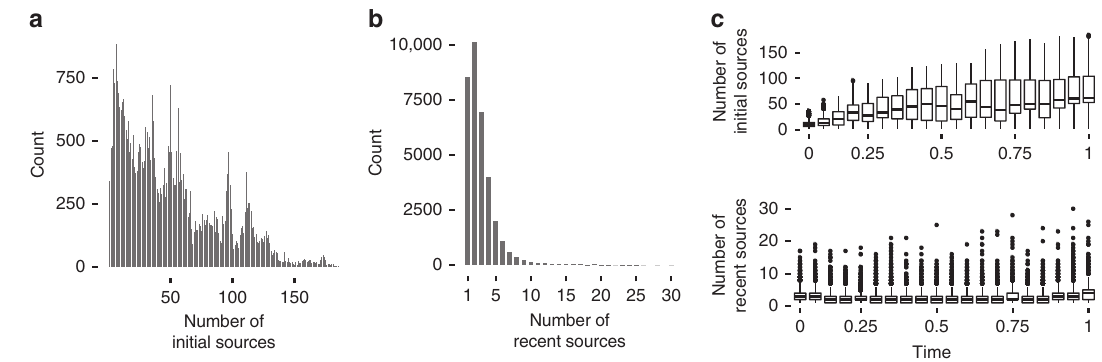
Fig. 5 Recombination over time. a Number of initial sources ( n = 42,072 — all entries excluding those that do not use recombination) and b number of recent sources for all the entries in all contests ( n = 37,474 — all entries that use recombination, excluding the ‘ Blackbox ’ contest, in which one single participant submitted a disproportionate amount of entries re fi ning their own solution, skewing the data); c number of initial and recent sources over time, averaging across all contests ( n =